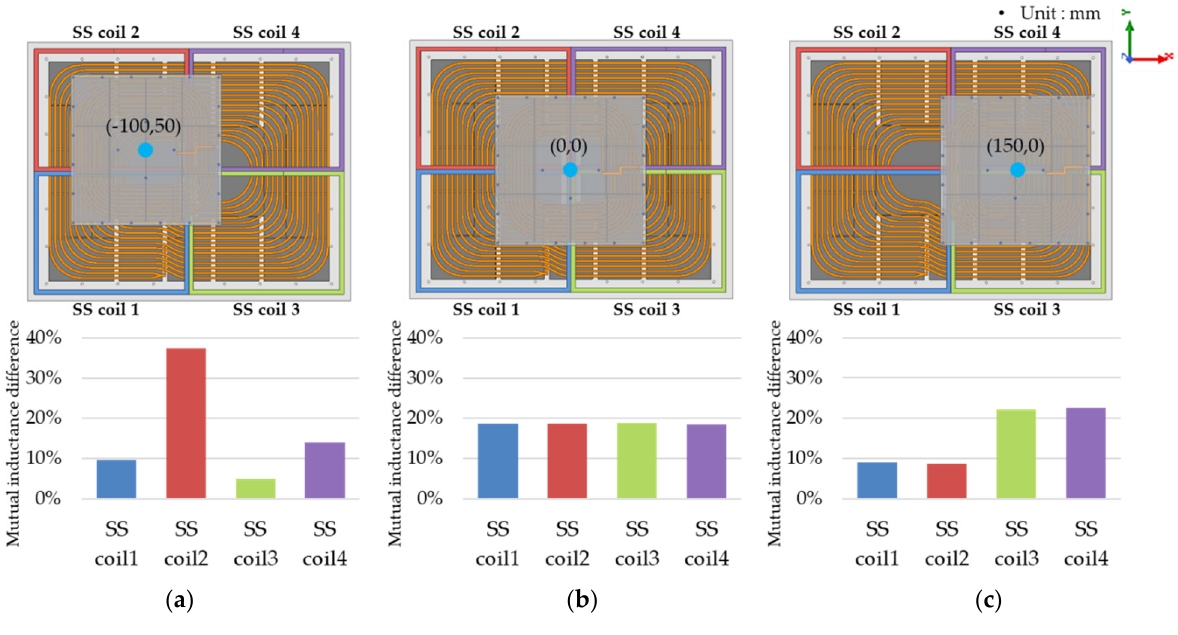
Figure 10. Mutual inductance difference of each SS coil according to the position of the receiver. ( a ) Receiver position: ( − 100,50). ( b ) Receiver position: (0,0). ( c ) Receiver position: (150,0).